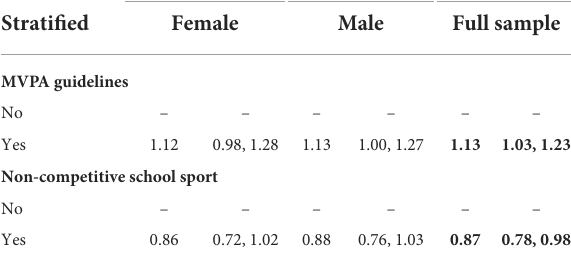
for females. For males who were highly connected to school, meeting the recommended minutes of MVPA was associated with a 4% increased odds of current cigarette smoking. However, based on Figure 1, both participants and non-participants saw a protective effect from school connectedness. For full